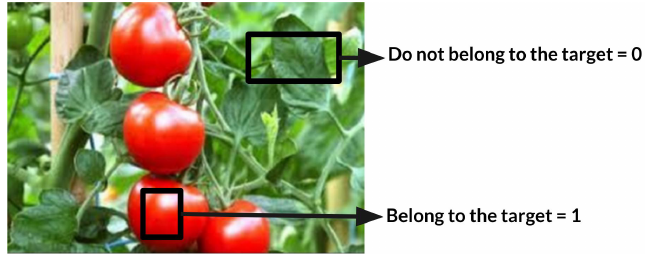
Figure 3. Pixel tagging